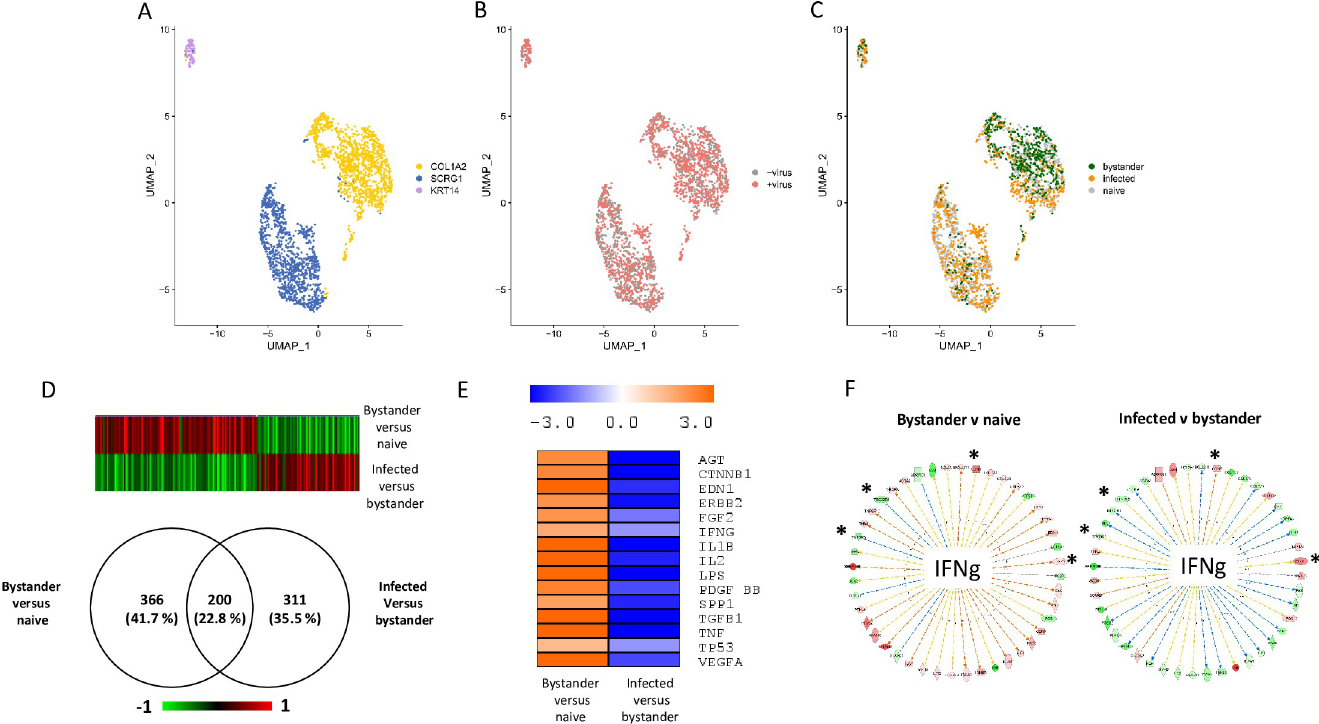
Fig 3. Single-cell transcriptomic analysis of TNBC infected with VV (experiment 1). Cells from TNBC were either mock infected or infected with VV (MOI = 5). Six hours later the cells were subjected to the 10X Genomics single-cell protocol, followed by sequencing. A : UMAP representing the three clusters annotated “COL1A2”, “SCRG1” and “KRT14” as these genes are top discriminents for the three clusters. B : Repartition of the cells incubated (red) or not (grey) with the virus. C : Repartition of na ï ve, bystander and infected cells in the three clusters. D : Venn diagram representing genes that are modulated in bystander versus na ï ve cells and infected versus bystander cells. The pattern of expression of the genes commonly regulated in the two differential analyses is presented as a heat-map. Red: gene upregulated, green gene down regulated. E : Ingenuity Pathways Analysis showing the upstream regulators describing differentially expressed genes in bystander versus na ï ve cells and infected versus bystander cells. Orange: pathway activated; blue: pathway inhibited. F : Example of genes that are part of the IFN γ pathway inversely regulated in bystander versus na ï ve cells and infected versus bystander cells. Genes in red are up-regulated and genes in green are down-regulated. Only four out of 44 genes (9.1%) are regulated in the same direction in the two conditions. These genes are noted: � . Details of the samples used to obtain these data are listed in S1 Table.